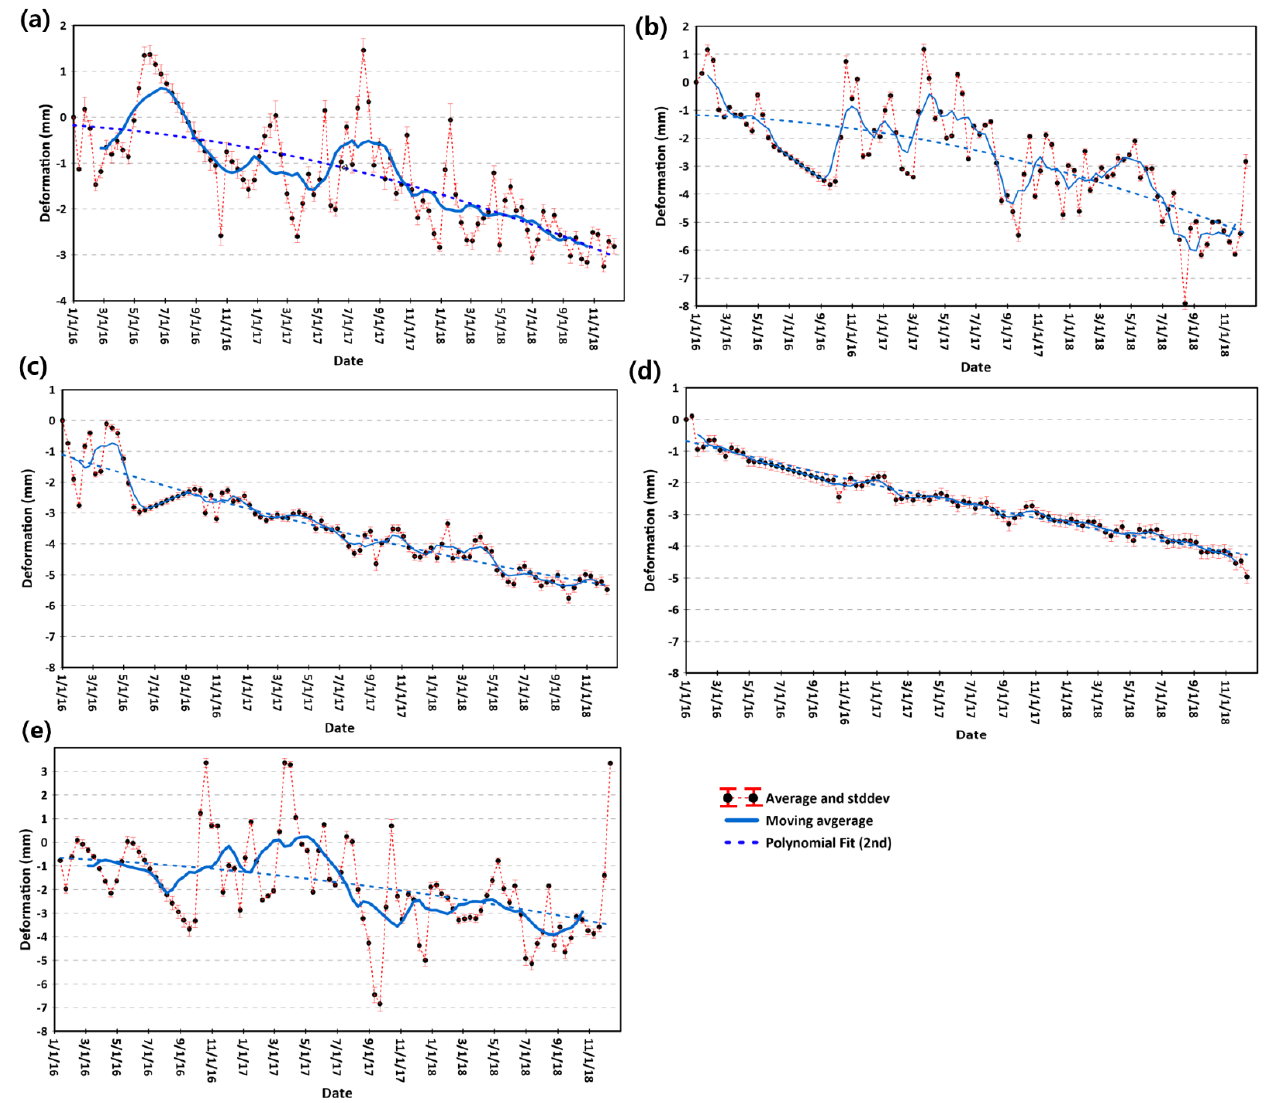
Figure 7. Deformations and standard deviations for training vectors on ( a ) collapse (PGS)-road crossing points, ( b ) Manjang cave-road crossing points, ( c ) deformation points in Seogwipo sediments, ( d ) deformation points in Jeju City urban area, and ( e ) deformations points on H-migrations. A five-window-sized moving average filter was applied to the original data set to observe the trend in the time domain.